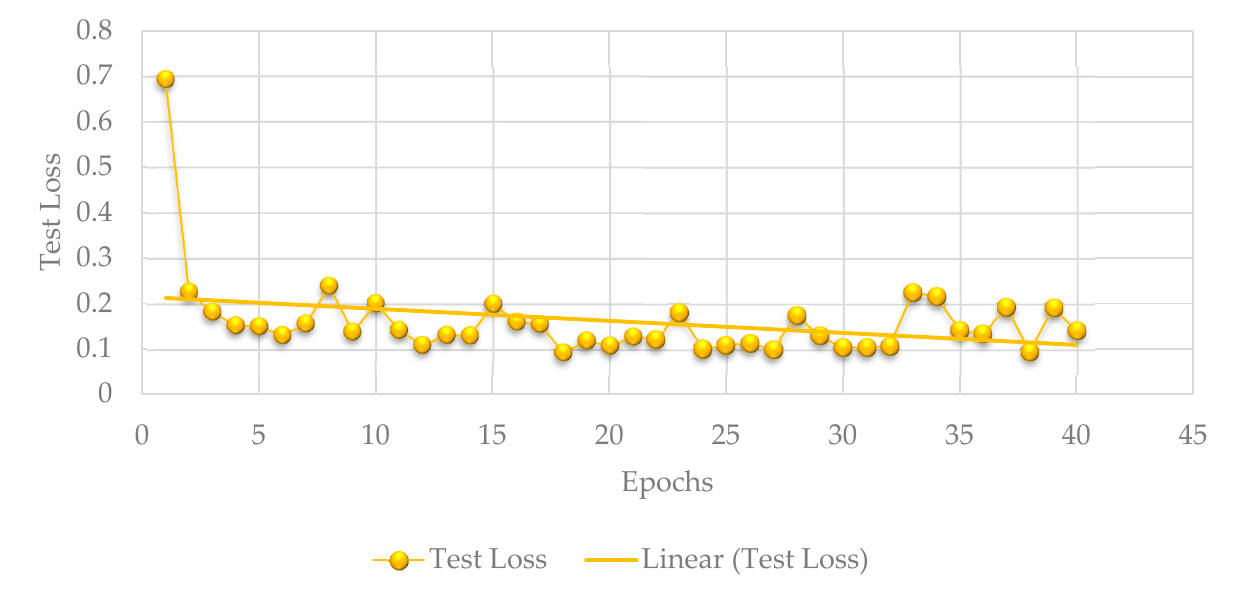
Figure 12. Trained model characteristics. 3.2. Statistical Performance Evaluation of the CNN As described in Section 2.4, 300 CXR samples in the validation dataset were tested in the proposed CNN and cross-checked against their clinical results as part of the validation